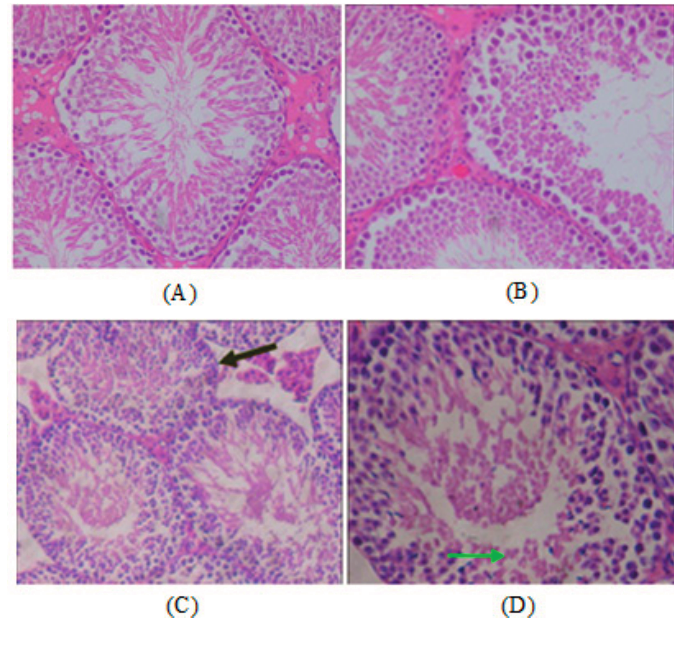
Figure 4. The testicular histopathological changes of the male rats. The control group ( A ); 45 mg/kg BW ( B – D ). Original magnification 200× and 400× (200× refers to picture A , B and C ; 400× refers to picture D ). The arrow on ( C ) points to disordered arrangement of cells in the tube and on ( D ) it points to cell